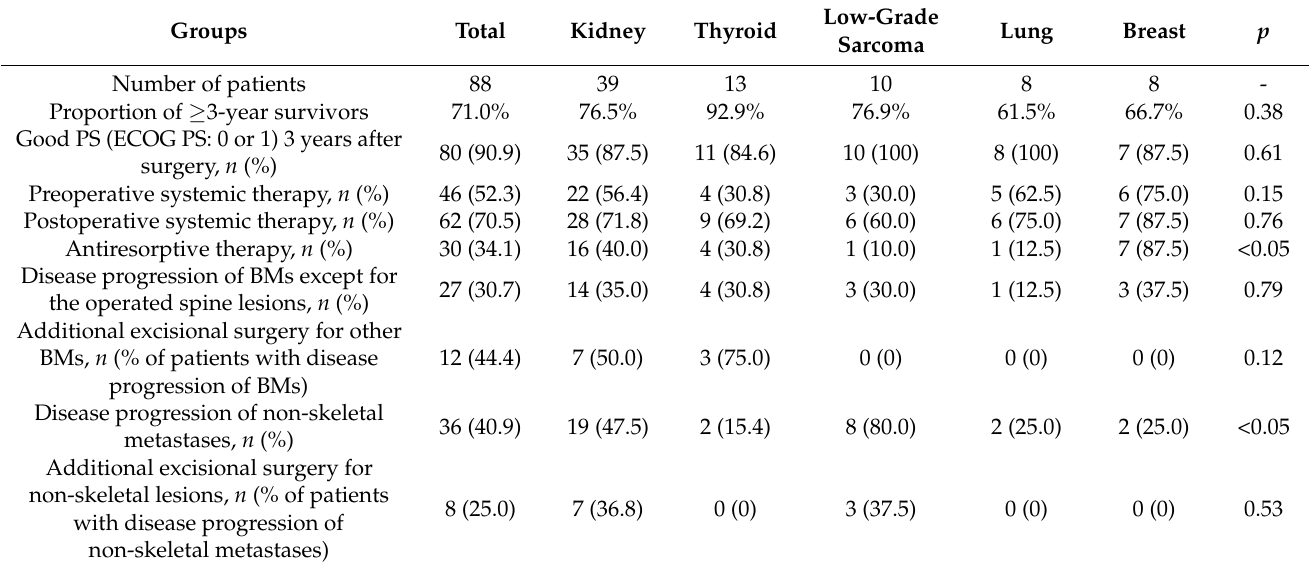
Table 3. Three-year clinical outcomes of patients who survived for more than 3 years after spinal